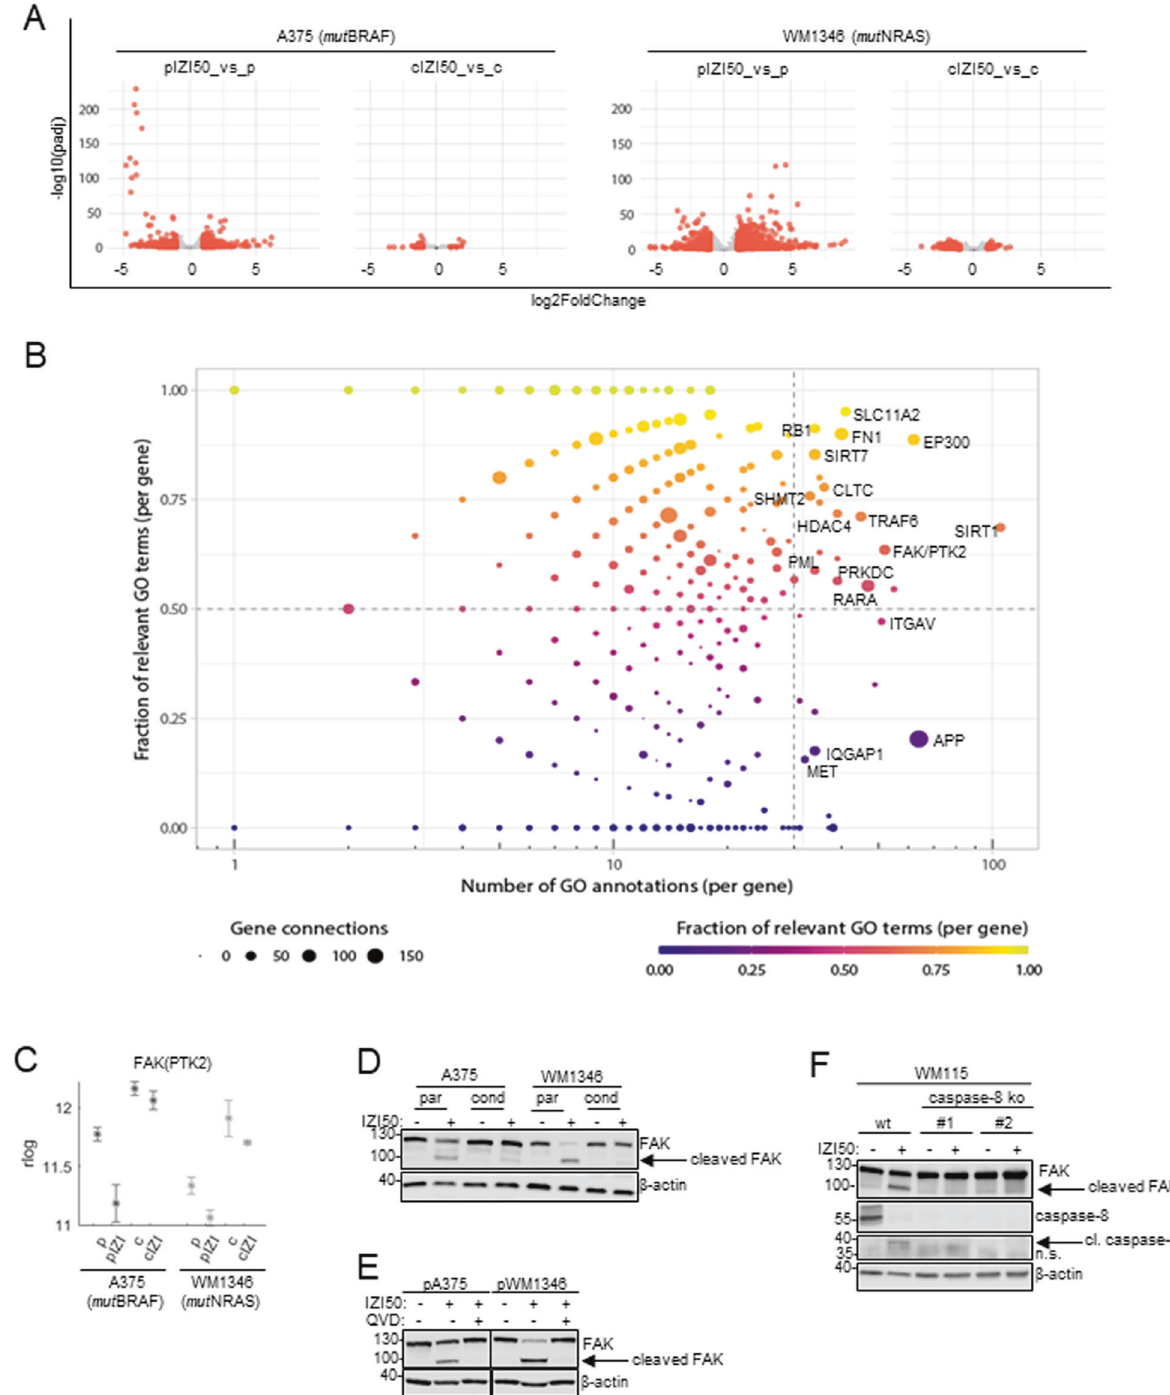
Tyr397 phosphorylation was markedly enhanced in IZI5- conditioned cells and remained unaffected upon IZI50-mediated TRAIL-receptor activation. Where present in parental cells, basal FAK-phosphorylation disappeared upon IZI50 stimulation, most likely due to FAK cleavage (Fig. 5D). In IZI5-conditioned mut BRAF A375 cells FAK activation coincided with PDK1- and PI3K-driven activation of downstream AKT, whereas mut NRAS WM1346 cells responded with PDK1- and PI3K-independent AKT activation as well as enhanced ERK-p38-cJun signaling, any of which is known Cell Death and Disease (2022)